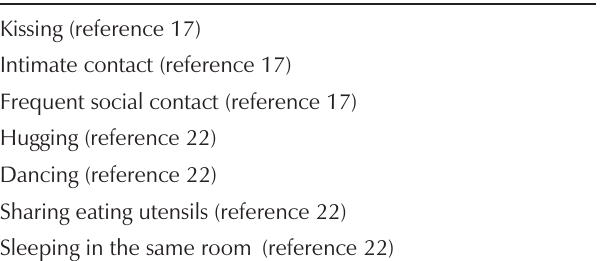
Factors associated with transmission of Burkholderia cepacia outside of